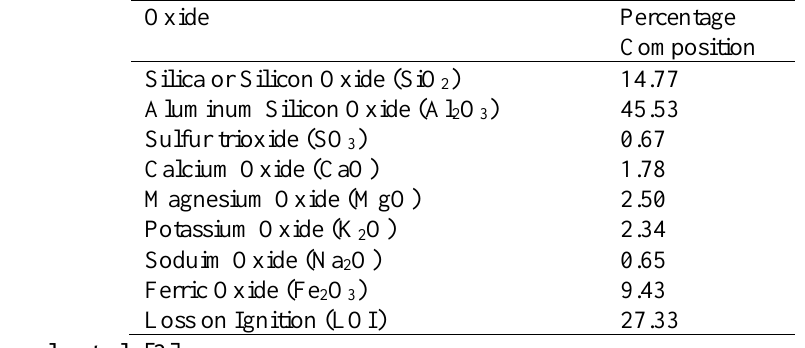
Chemical composition of coal from Odagbo coal mine. Oxide